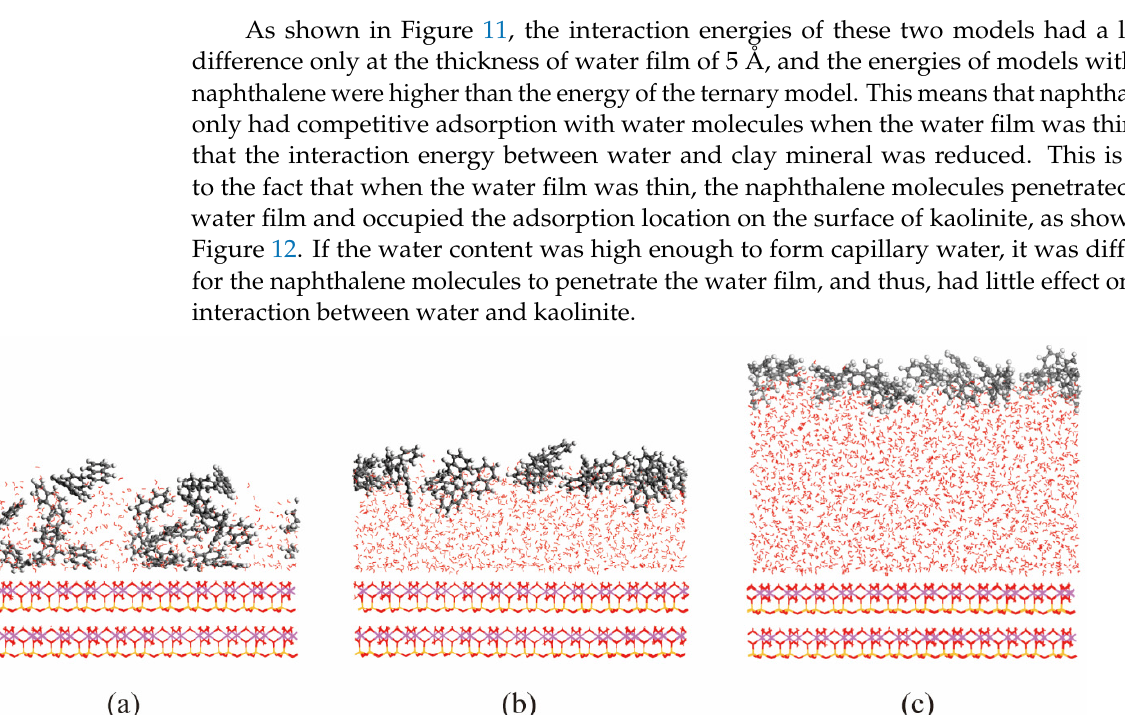
Figure 11. The total interaction energies and average interaction energies between the water molecules and kaolinite (alumina octahedral surface) under the different thicknesses of the aqueous layer.